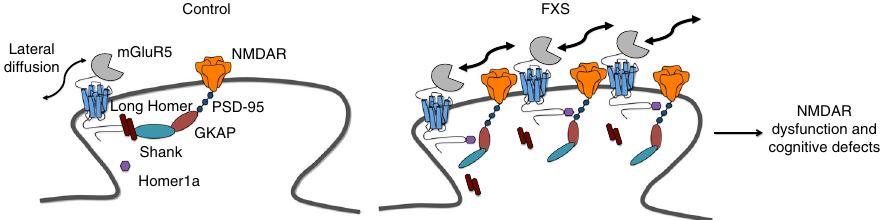
Fig. 7 Model for dysfunction of the NMDAR/mGluR5 crosstalk in Fmr1 KO neurons. In WT neurons, long Homer proteins anchor mGluR5 to a chain of PSD proteins in the synapse and prevent a direct interaction with NMDAR. Under those conditions, a co-clustering of mGluR5 and NMDAR is prevented. In Fmr1 KO neurons, mGluR5 is less associated with the long Homer proteins and more associated with the short isoform, Homer1a. This disengagement from the long Homer protein – containing complex increases the lateral diffusion of mGluR5 and promotes its interaction with synaptic NMDAR. This con fi guration at the synapse prevents boosting of NMDAR currents under control conditions and their LTD following mGluR5